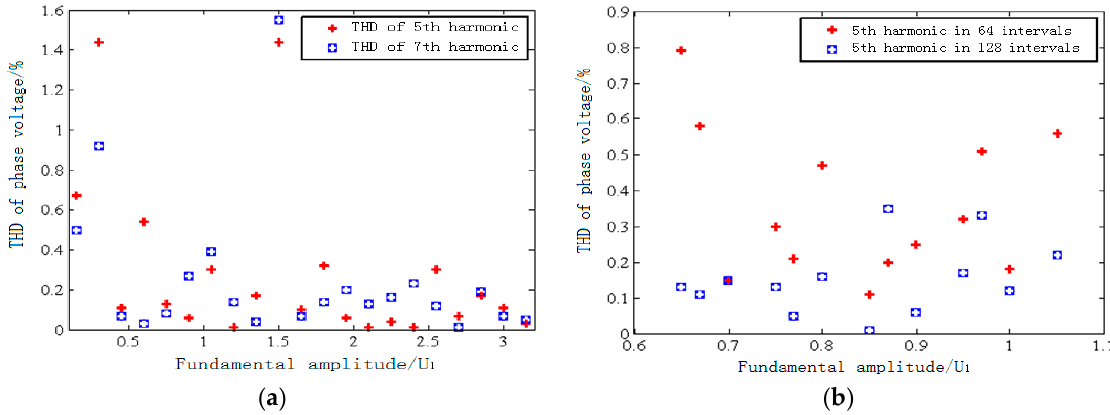
( b ) Figure 7. Simulation waveform based on the C waveband when U1 = 1.0. ( a ) Simulation waveforms of phase and line voltages. ( b ) Spectrum distribution of phase and line voltages. As shown in the Figure 7a, the phase voltage V AN is 3 levels, while the line voltage V AB is 5 levels, which conforms to the design of the C band. From Figure 7b, it can be seen that the THD of phase voltage V AN is 47.48%, in which the 5th and 7thharmonics are eliminated. The THD of line voltage V AB is 32.66%, in which the 3rd, 5th, and 7th times harmonics are eliminated, which proves the correctness of the switch angle calculation. As shown in Figures 5 − 7, the 5th and 7th harmonics have basically been eliminated, which can be proved using the control technology of the SHEPWM multilevel inverter based on the Walsh transform, combined with multiband modulation, which is feasible in this paper. Because of the limitation of the calculation accuracy and the precision of the numerical algorithm needed to solve